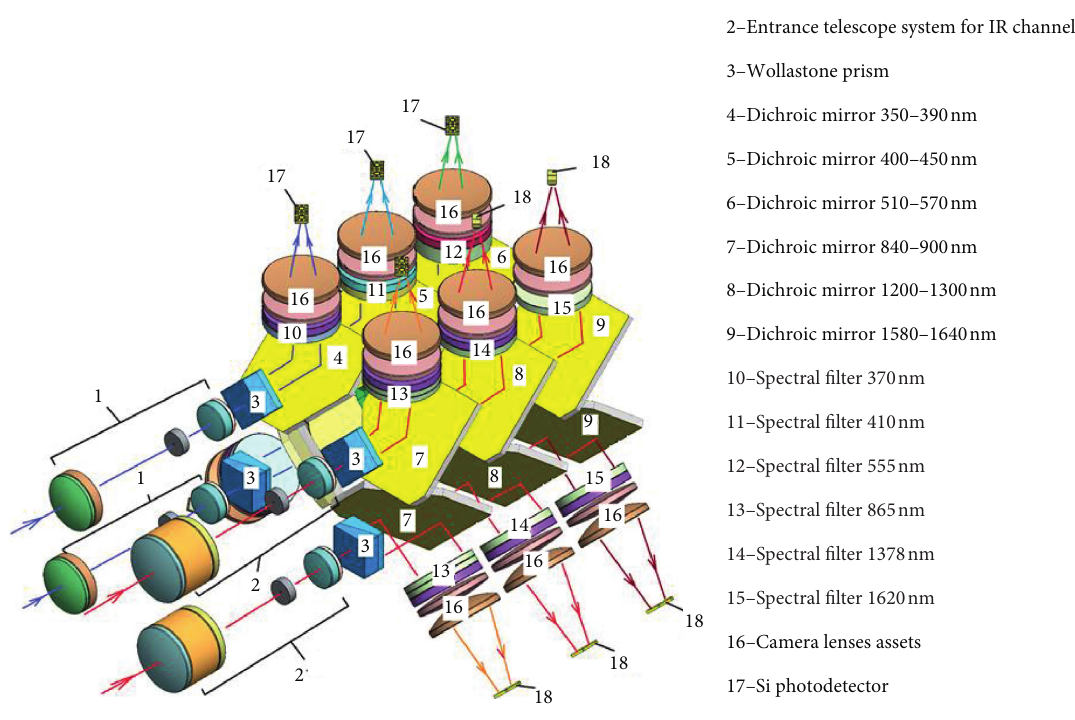
Figure 1: ScanPol polarimeter optical layout.